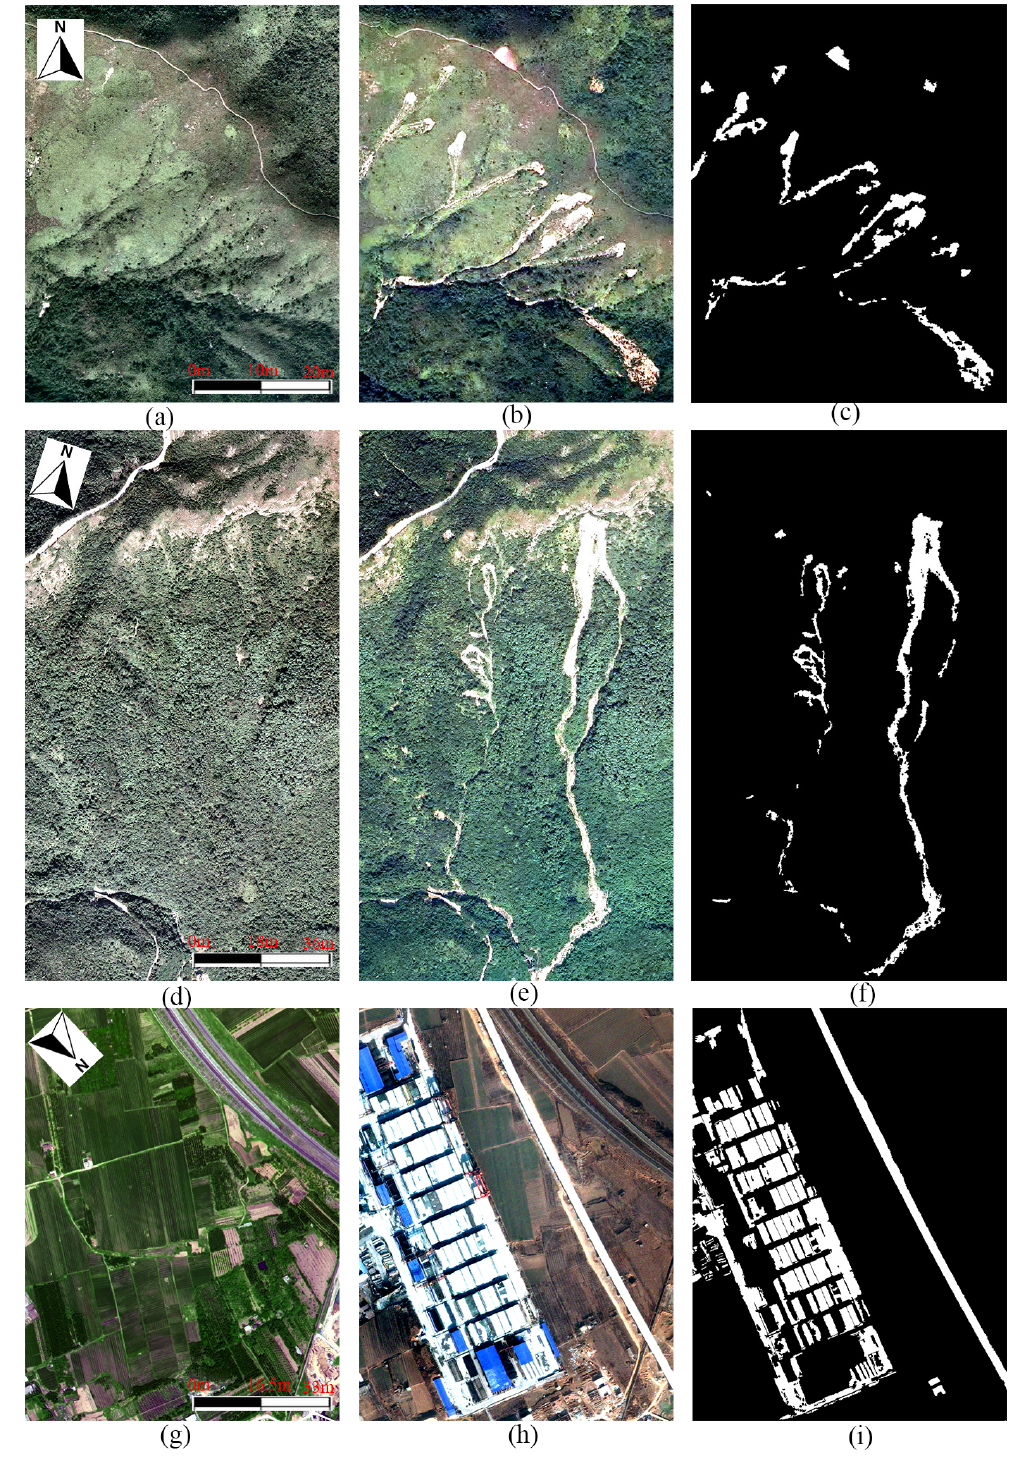
Figure 3. False color bi-temporal images for land cover change detection: ( a ) Pre-landslide image of Hong Kong, Site A; ( b ) Post-landslide image of Hong Kong, Site A; ( c ) Ground reference for the landslide in Hong Kong, Site A; ( d ) Pre-landslide image of Hong Kong, Site B; ( e ) Post-landslide image of Hong Kong, Site B; ( f ) Ground reference for the landslide in Hong Kong, Site B; ( g ) Pre-event image of Ji’Nan QuickBird data; ( h ) Post-event image of Ji’Nan QuickBird data; ( i ) Ground reference for the Ji’Nan QuickBird.